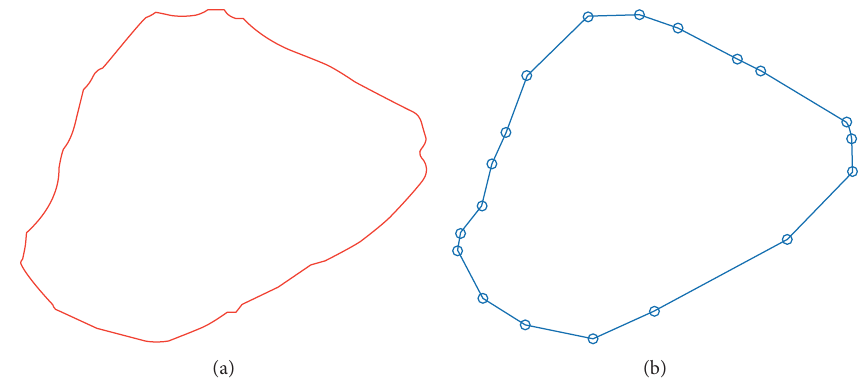
Figure 1: Contour points’ simplification. (a) Original contour points and (b) key control